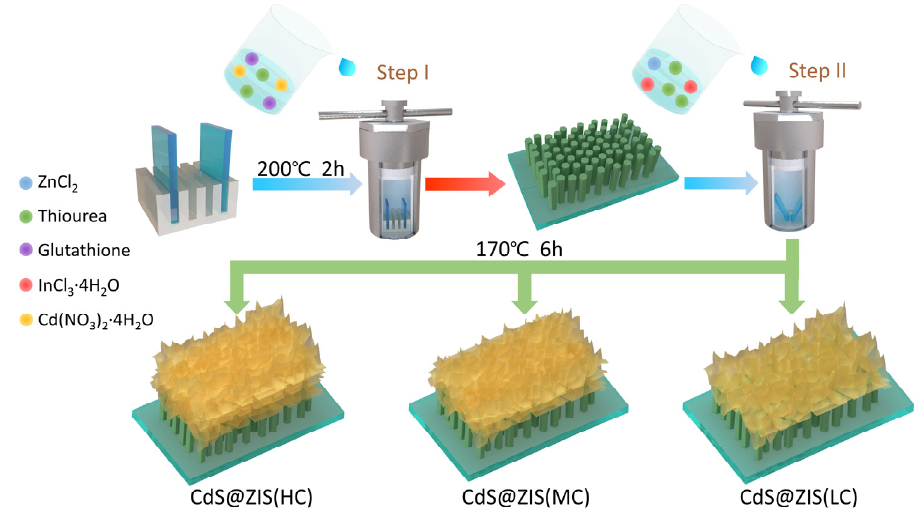
Figure 1. Schematic illustration of the fabrication process of CdS NRs and CdS@ZIS photoanodes. For comparison, three kinds of ZIS precursor concentrations were adopted and noted as HC (high concentration), MC (medium concentration), and LC (low concentration), respectively.